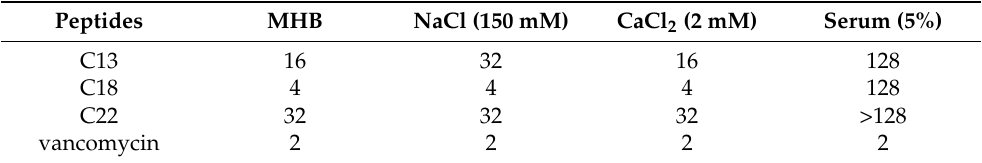
Table 2. The effects of salts and serum on peptide activity against S. aureus MW2, MIC ( µ g/mL).